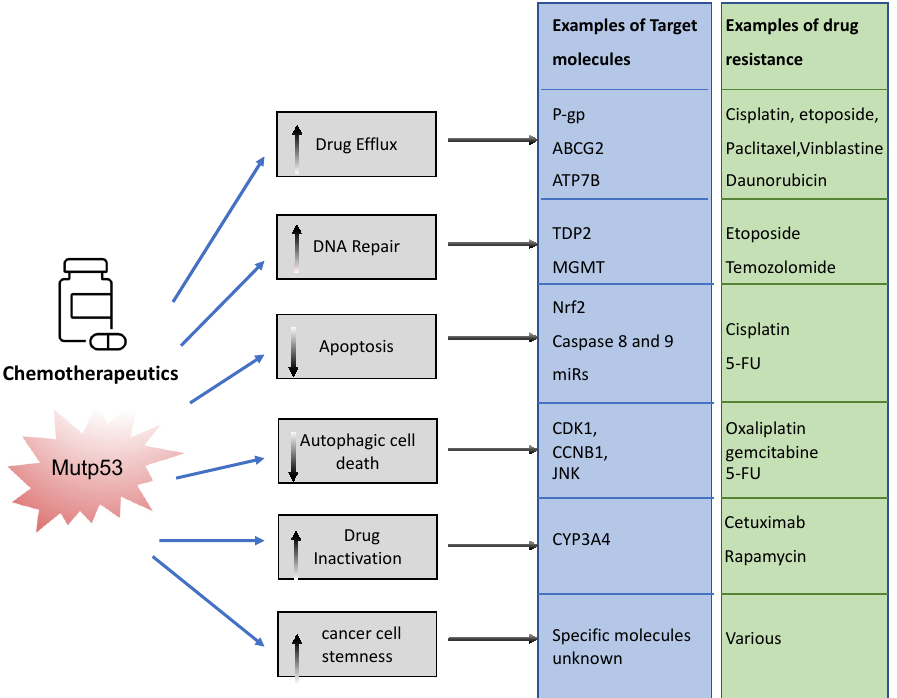
Figure 3. Examples of ways in which mutant p53 promotes chemoresistance. Mutant p53 can impact various cellular processes to prevent chemotherapeutics drugs from working. It can neutralize chemotherapy, promote efflux and impair the way in which these drugs promote cancer cell death. This figure shows examples of these pathways.